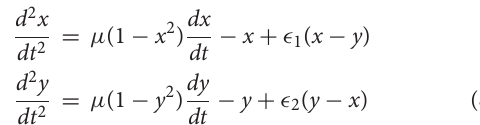
TABLE 1 | Description of the four RQA measures RR, DET, ADL, and LDL. Measure